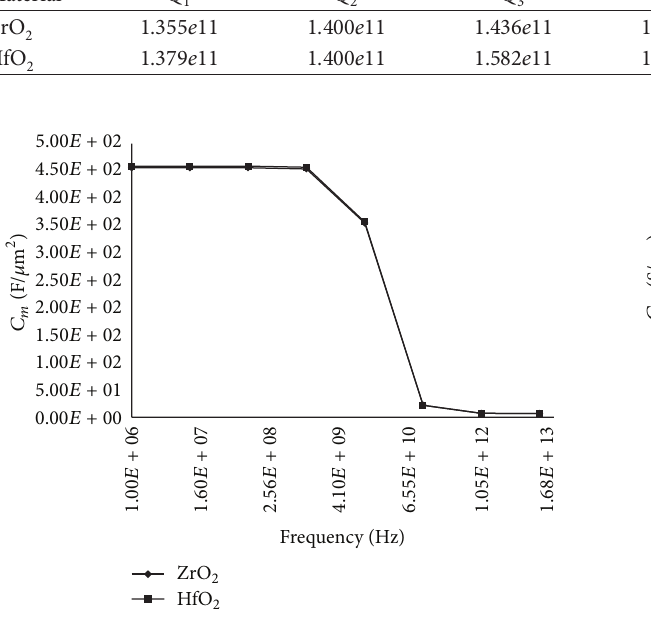
shows that the local maximum of each curve indicates the . The peaks of the curves used for the magnitude of 𝐷 it oxide materials mean that the interface state energy levels are measured. Both 𝐺 𝑝 /𝜔 and 𝐺 𝑝 will peak as a function of bias voltage at gate terminal but only 𝐺 𝑝 /𝜔 will peak as a function of frequency. 𝐺 𝑝 /𝜔 will peak at a lower frequency when admittance is measured as a function of frequency with bias voltage at the gate as parameter or at the gate bias near to flatbands and when admittance is measured as a function of bias voltage at the gate with frequency